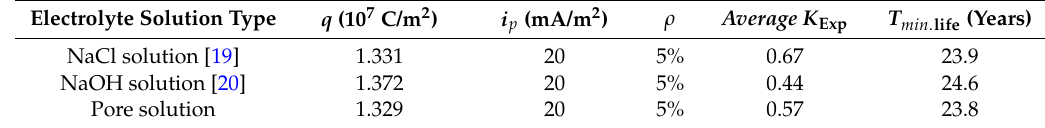
Table 4. Comparison of the service life of the ICCP system in the different electrolyte